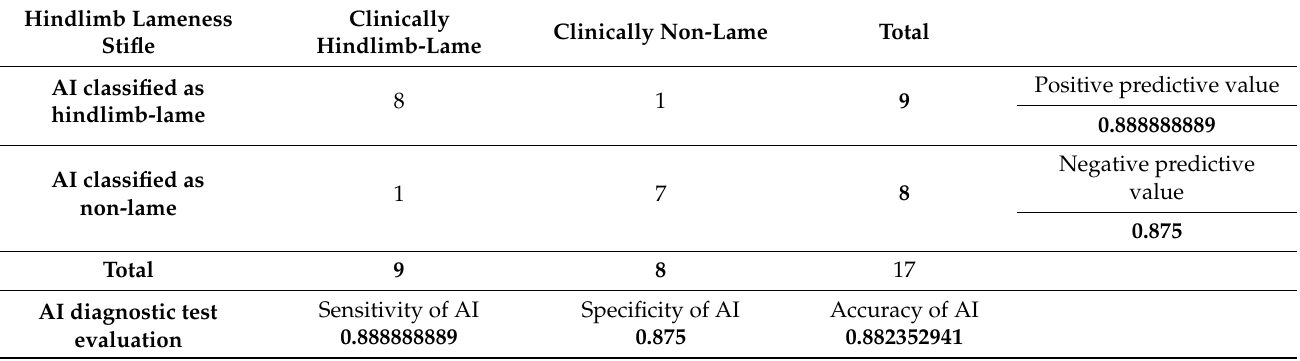
Table A5. Stifle reference point—Statistical classification of horses with and without hindlimb lameness.